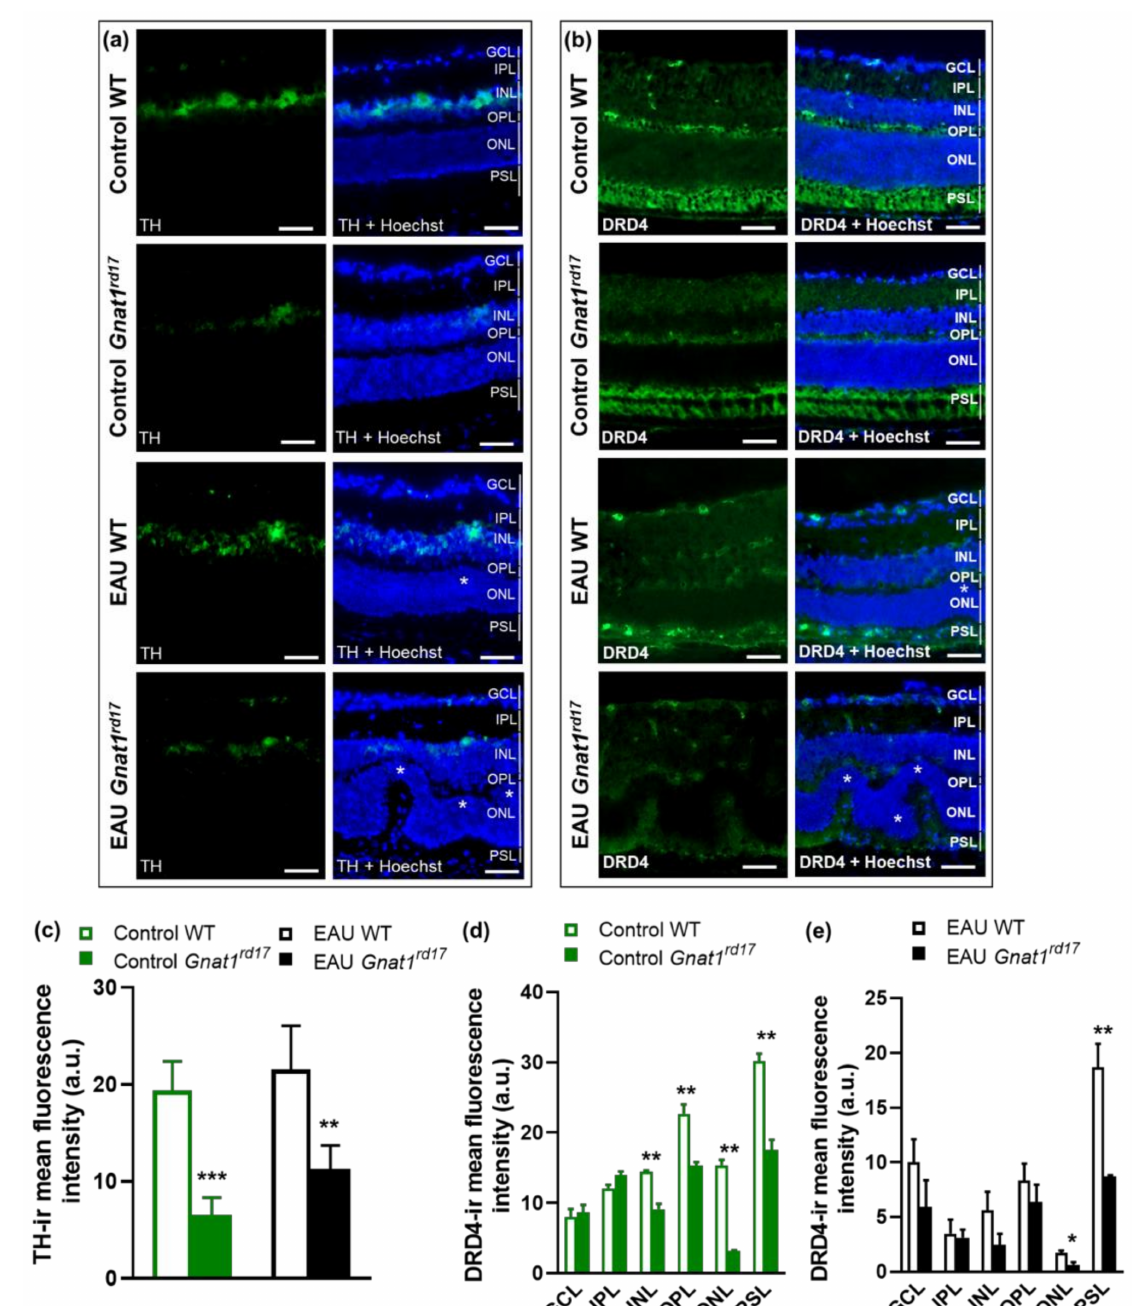
Figure 6. Gnat1 rd17 mice exhibit decreased TH and DRD4 protein expressions in the retina. Rep- resentative immunofluorescence staining (green) of ( a ) TH and ( b ) DRD4 protein expression and quantitative analysis of mean fluorescence intensities of ( c ) TH in the INL and ( d , e ) DRD4 expressions within all retinal layers in WT and Gnat1 rd17 mice, control and with EAU on day 14 after immu- nization, respectively. Retinal detachments that show retinal folds are indicated by white asterisks. Shown is one of two experiments with similar results. The data are presented as the mean ± SEM of 6 retinas from 6 mice per group. Differences between WT and Gnat1 rd17 groups: * p < 0.05, ** p < 0.01, and *** p < 0.001 (unpaired t -test). Blue, Hoechst staining of nuclei. GCL, ganglion cell layer; IPL, inner plexiform layer; INL, inner nuclear layer; OPL, outer plexiform layer; ONL, outer nuclear layer; PSL, photoreceptor segment layer. The scale bar shows 50 µ